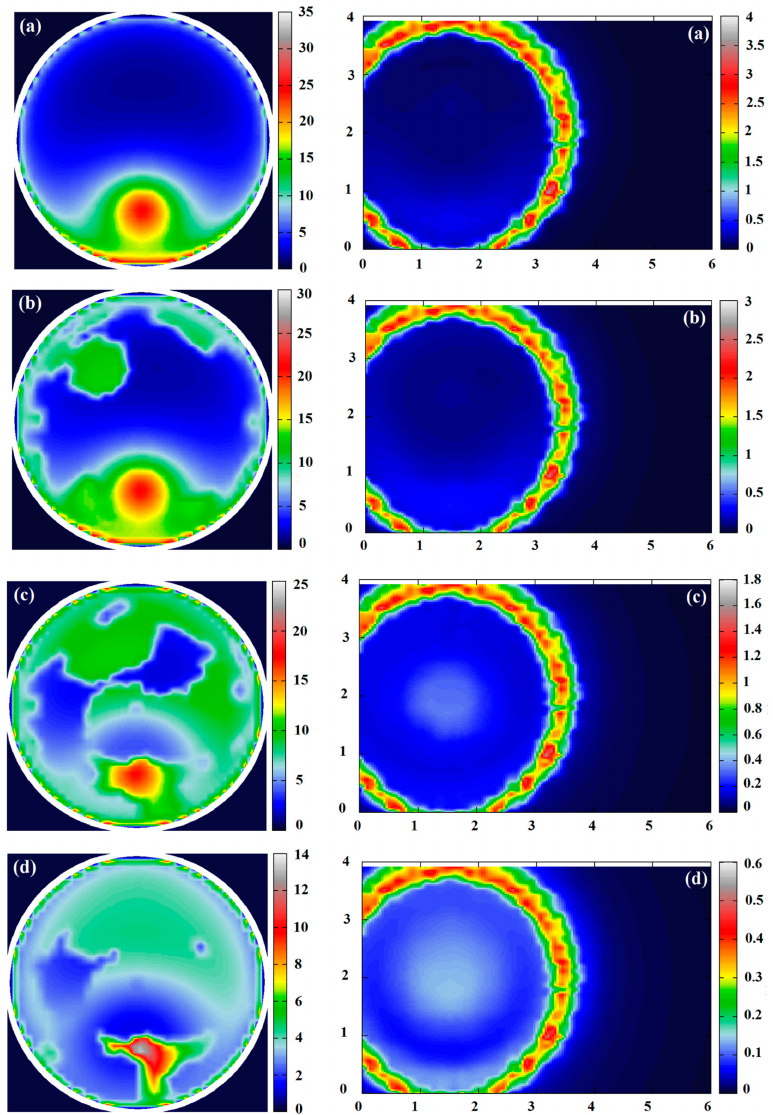
Figure 3. Sky luminance distribution in kcd.m − 2 (left plots) and work-plane illuminance in klx (right plots) computed for the following cloud fractions (from top to the bottom): ( a ) 0.0, ( b ) 0.15, ( c ) 0.30, and ( d ) 0.45. The solar altitude is 45 ◦ .The light guide with a radius of 0.26 m and length of 1.5 m is considered. Room dimensions are in meters (see plots on right side of the